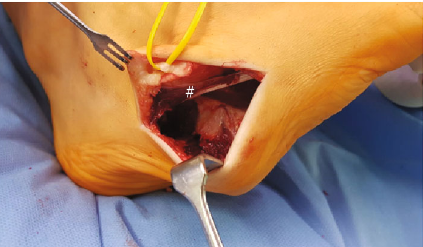
Figure 5: Intraoperative photograph demonstrating the lateral approach: reduction-plasty of the abductor digiti minimi muscle (#) and nervus suralis retracted with a vessel loop.